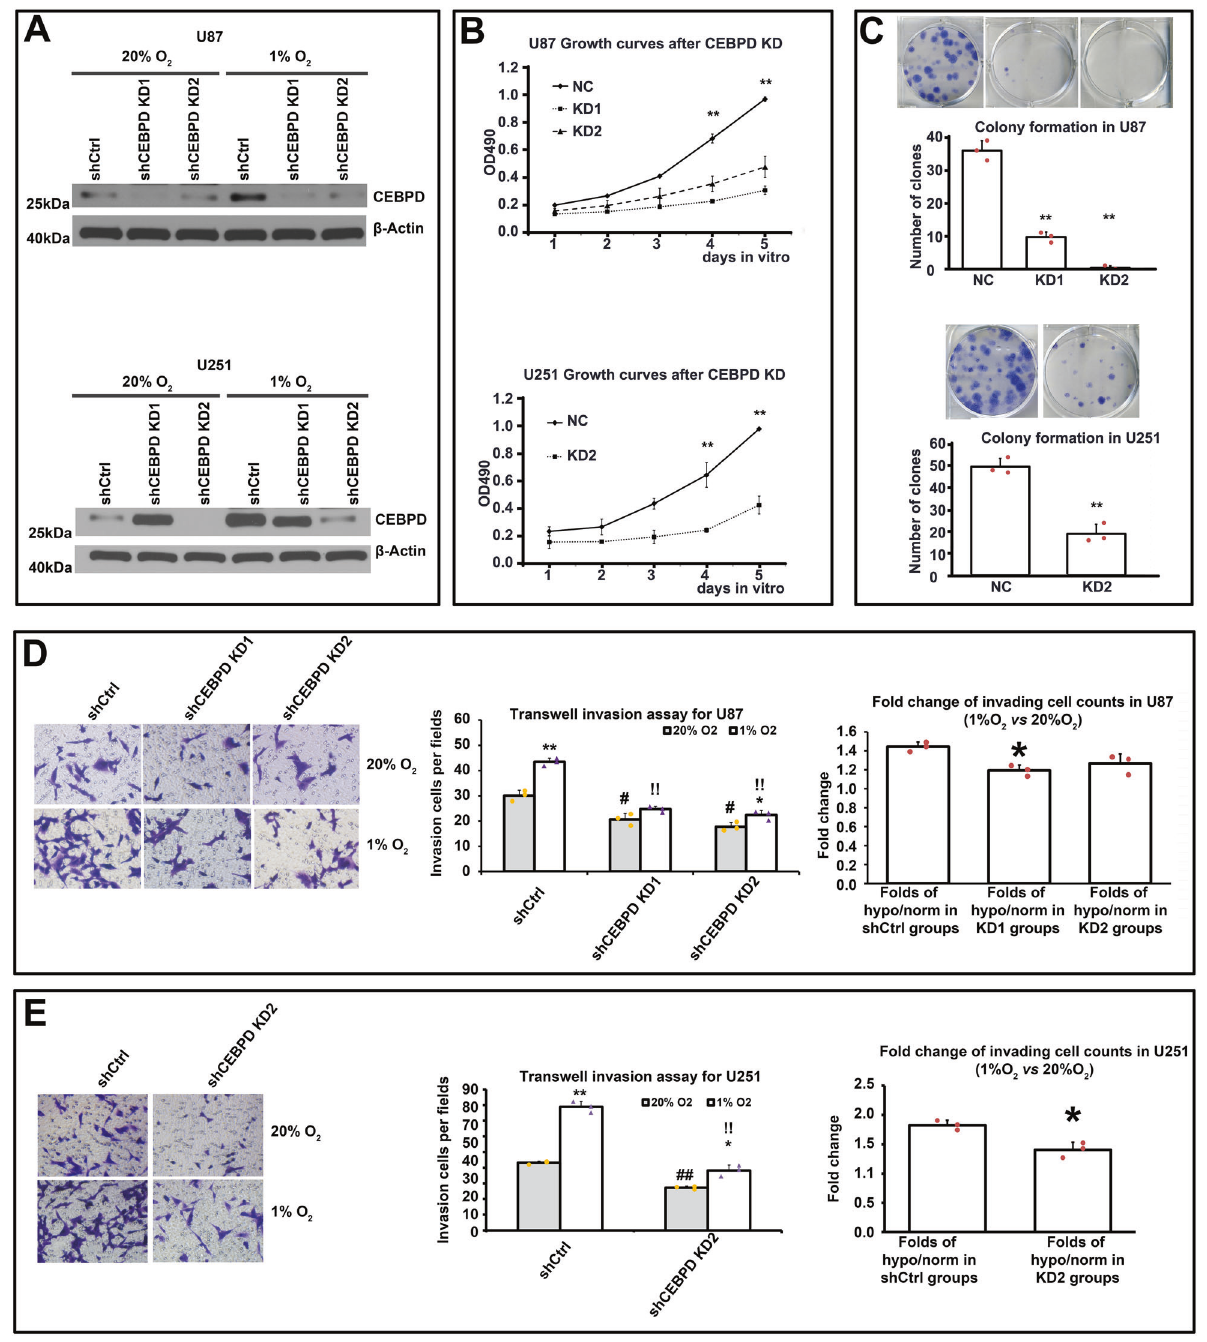
Fig. 3 knockdown of CEBPD inhibited invasion capacity of GBM cells. A WB assays showing proteins levels of CEBPD after shCEBPD lentiviruses infection in U87 (up panel) and U251 (bottom panel) cells, in normoxia (20% O 2 ) or hypoxia (1% O 2 ) conditions. B In vitro CCK8 assays showing the effect of CEBPD knockdown on growth curves for U87 (up panel) and U251 cells (bottom panel). C In vitro colony formation assays of U87 (up panel) and U251 (bottom panel) cells with shCtrl or shCEBPD infection. D , E Transwell invasion assays of U87 ( D ) and U251 ( E ) cells infected with shCtrl or shCEBPD lentiviruses in normoxia (20% O 2 ) or hypoxia (1% O 2 ) conditions. ** p < 0.001, * p < 0.05, compared with corresponding normoxia (20% O 2 ) group; # p < 0.05 compared with shCtrl group in normoxia (20% O 2 ); ! p < 0.05 compared with shCtrl group in hypoxia (1% O 2 ). Right images in ( D , E ): Fold increase of number of hypoxia induced invasion cells after shCtrl or shCEBPD treatment in U87 ( D , right image) and U251 ( E , right imag) cells. Repeated data for each group were obtained by calculating the ratio of each hypoxia data to the averaged value of normoxia data. * p < 0.05, compared with shCtrl group. Experiments were repeated in triplicate. after CEBPD KD (Fig. 6F), and Chip-qPCR con fi rmed the binding of sites from the JASPAR database [43], a peak fragment was CEBPD to this FN1 promoter region (Fig. 6G). Luciferase reporter identi fi ed from the Chip-seq data in the FN1 promotor region, assay results demonstrated that CEBPD can bind and activate this which contained putative CEBPD binding sites with high scores sequence (Fig. 6H). In addition, the mutation of the putative (Fig. 6E). Notably, the mRNA level of FN1 was signi fi cantly reduced